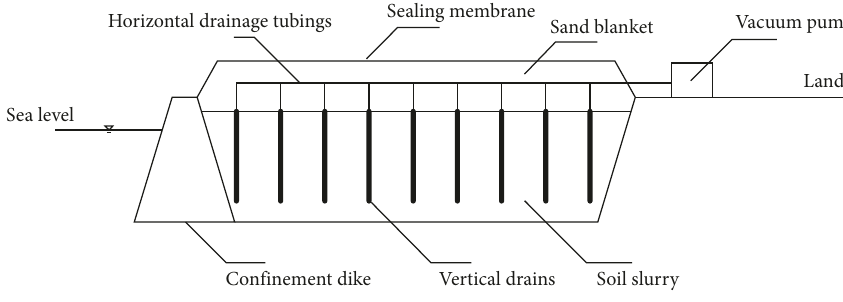
Figure 1: Vacuum preloading system.